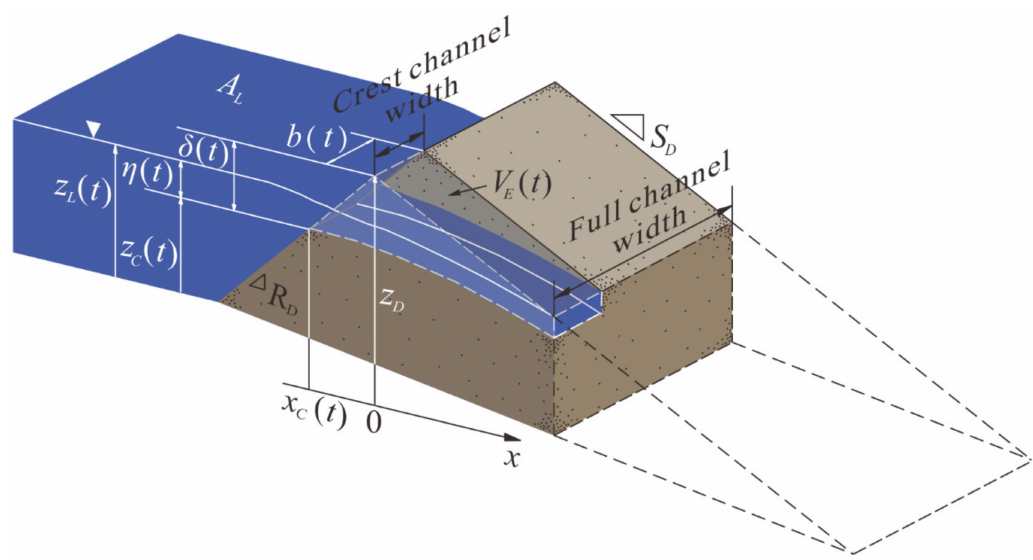
Figure 4. Schematic and parameters of the proposed dam breach